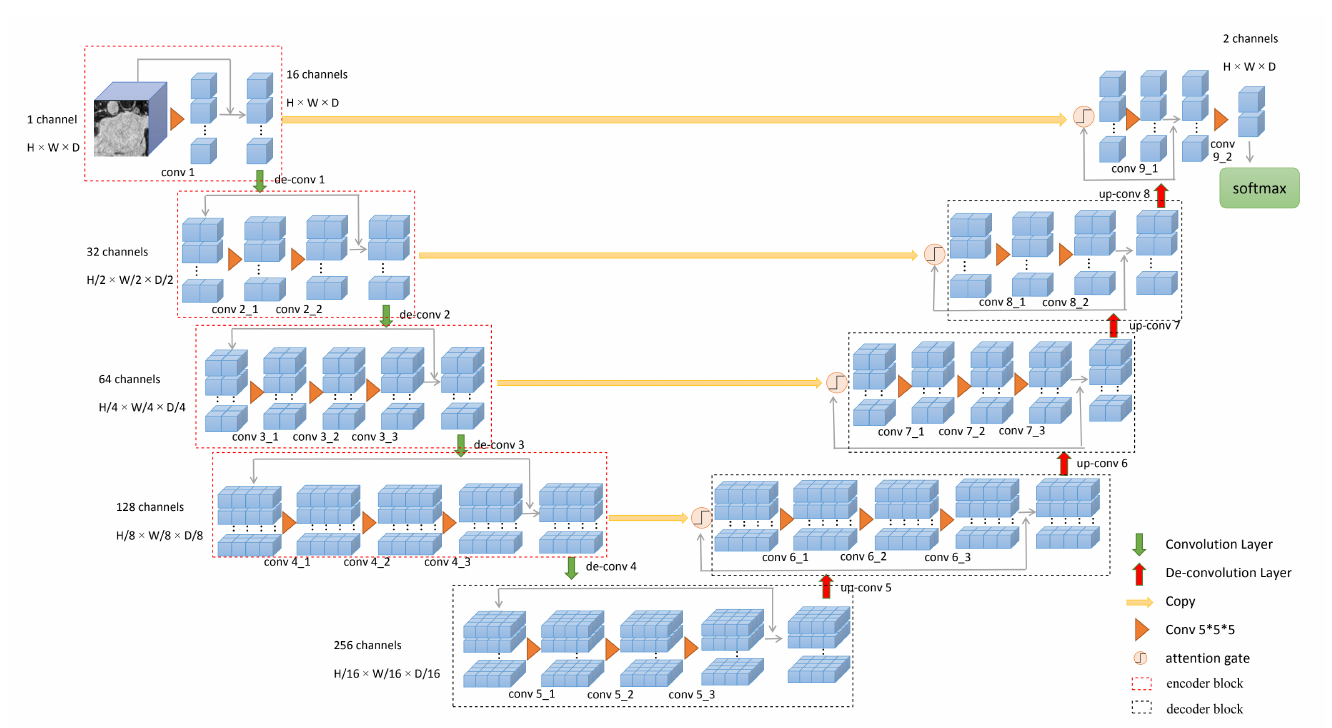
Figure 1. The proposed